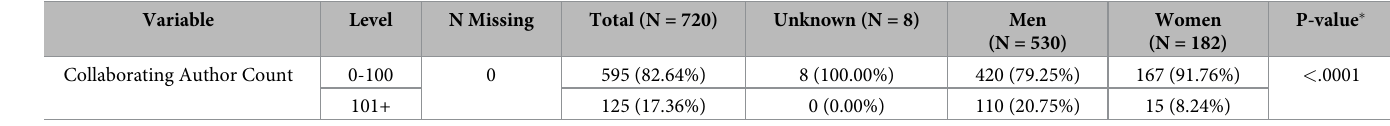
Table 3. Top medical research journals: First authors’ publication’s characteristics by gender (2008 to